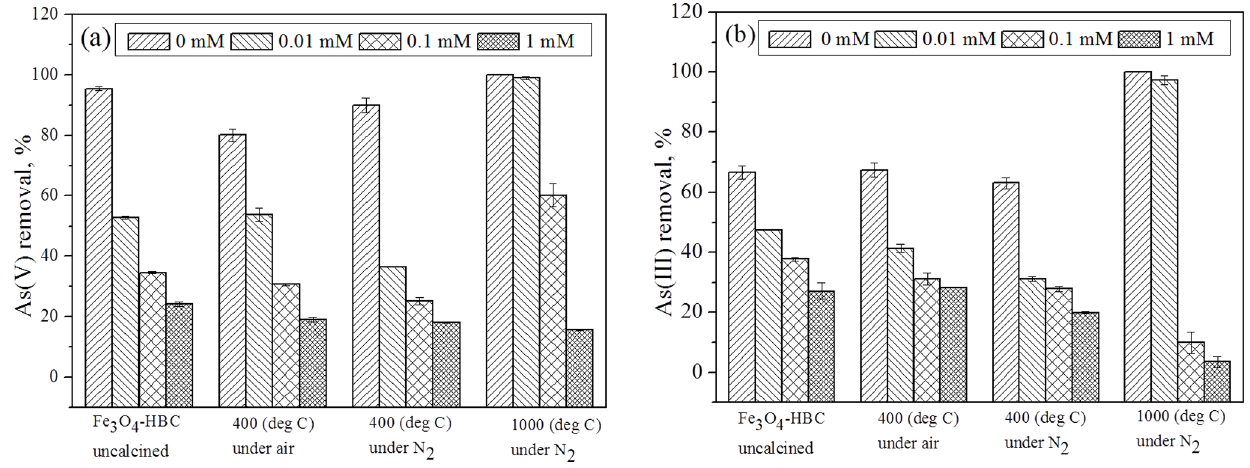
Figure 7. Effect of phosphate concentrations (0–1 mM) on the adsorption of As(V) (a) and As(III) (b) using uncalcined and calcined Fe 3 O 4 -HBC composite. Experiment conditions: adsorbent dose =0.02 g 100 mL 2 1 , temperature =25 6 0.8 u C, agitation speed =150 rpm, initial concentration =100 m g L 2 1 , contact time =14